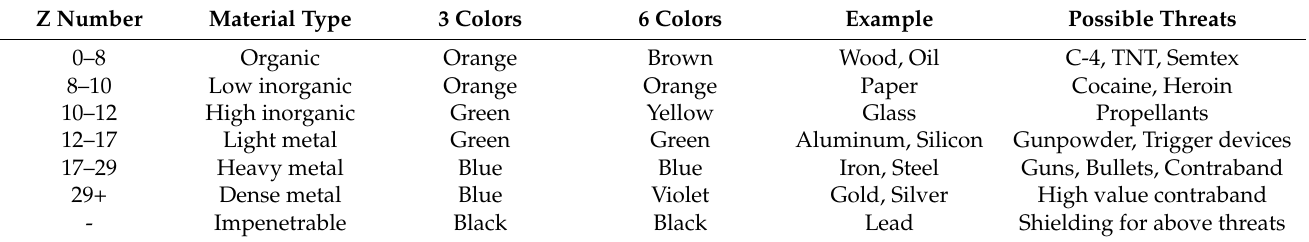
Table 1. Material pseudo-colors and their classes commonly utilized in X-ray security